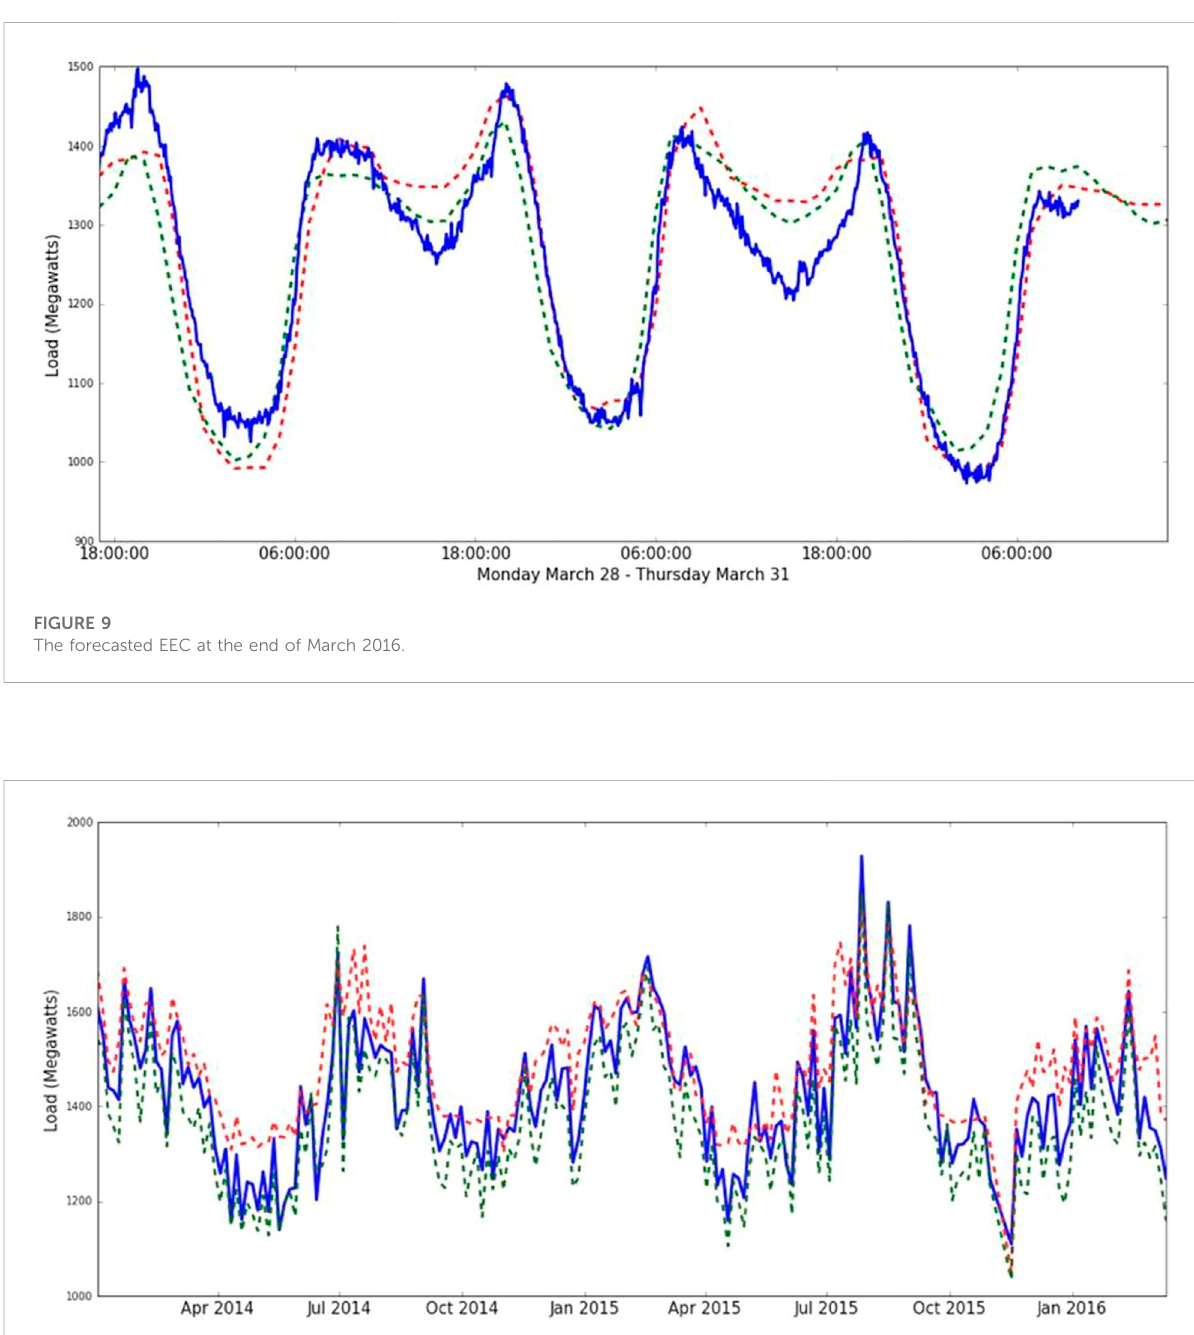
FIGURE 10 The average daily EEC from April 2014 to January